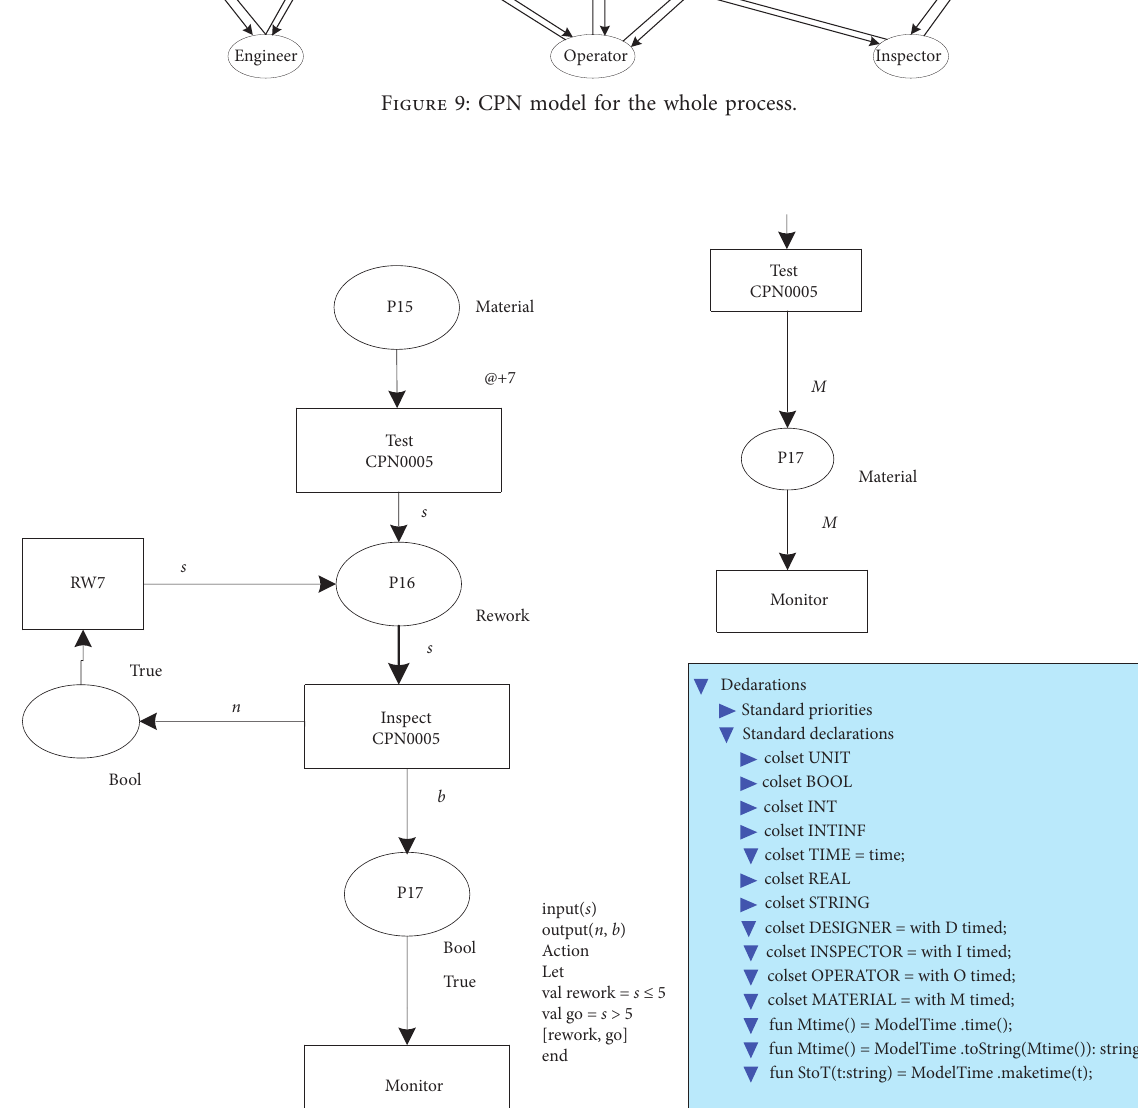
Figure 10: Rework structure and output